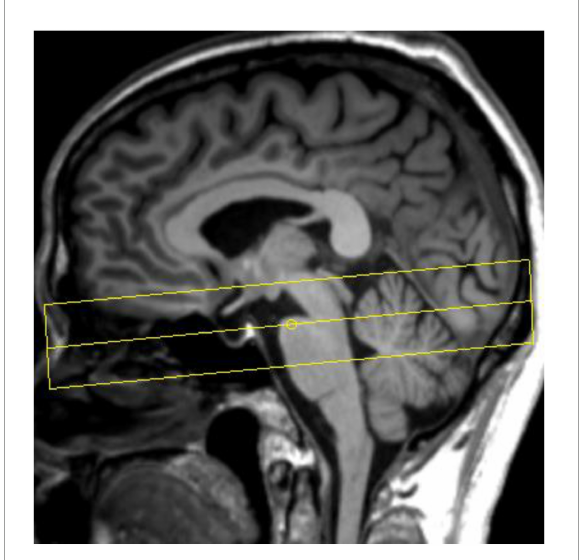
FIGURE2 Schematic diagram of neuromelanin-sensitive magnetic resonance imaging (NM-MRI)